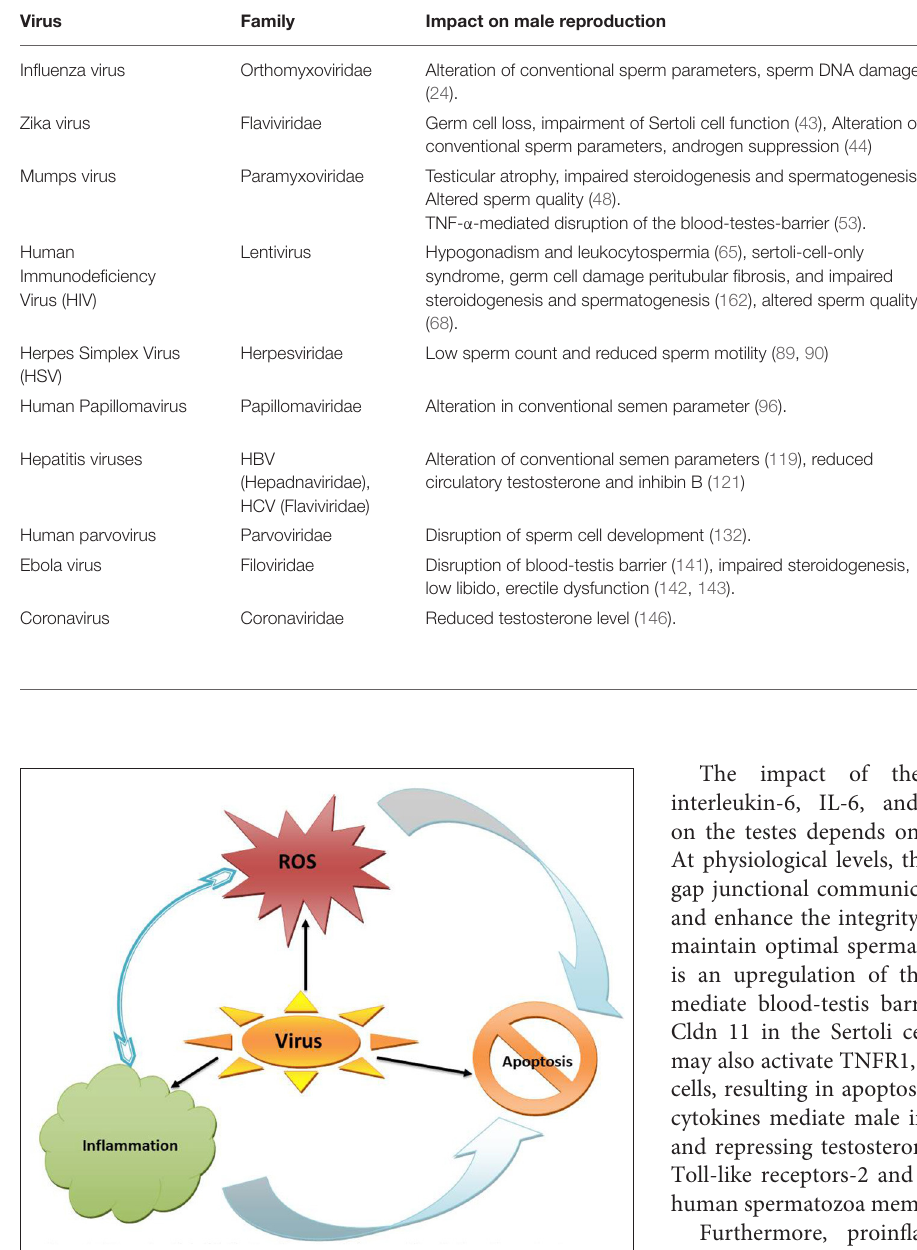
FIGURE 1 | Enhanced generation of reactive oxygen species (ROS) could be a cause or consequence of inflammation; both of which can be triggered by viral infection and results in